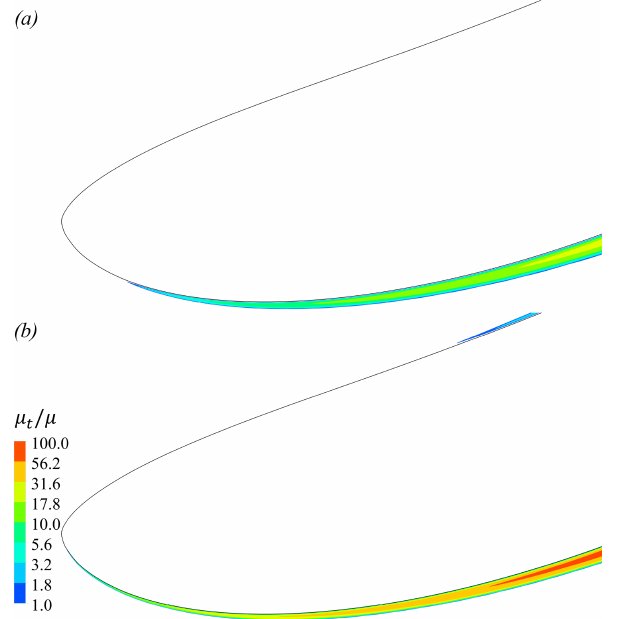
Figure 10. Eddy viscosity ratio contours near the leading edge of the duct for the optimal design ( c/D = 0 . 18, C T = 0 . 91, α = 31 ◦ , (cid:49)n/c = 0 . 040, z rotor /l = 0 . 85) at (a) Re c = 3 × 10 5 and (b) Re c = 1 . 2 × 10 6